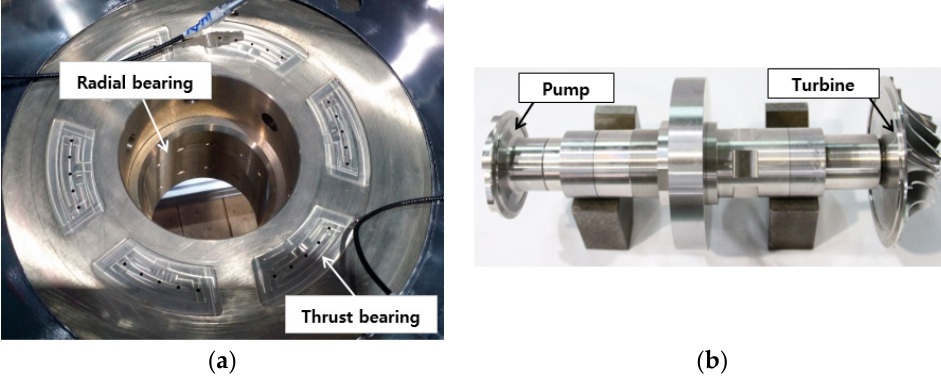
Figure 11. Pump-drive turbine assembly. ( a ) Radial and thrust bearing; ( b ) Rotor and impeller. Appl. Sci. 2020 , 10 , x FOR PEER REVIEW